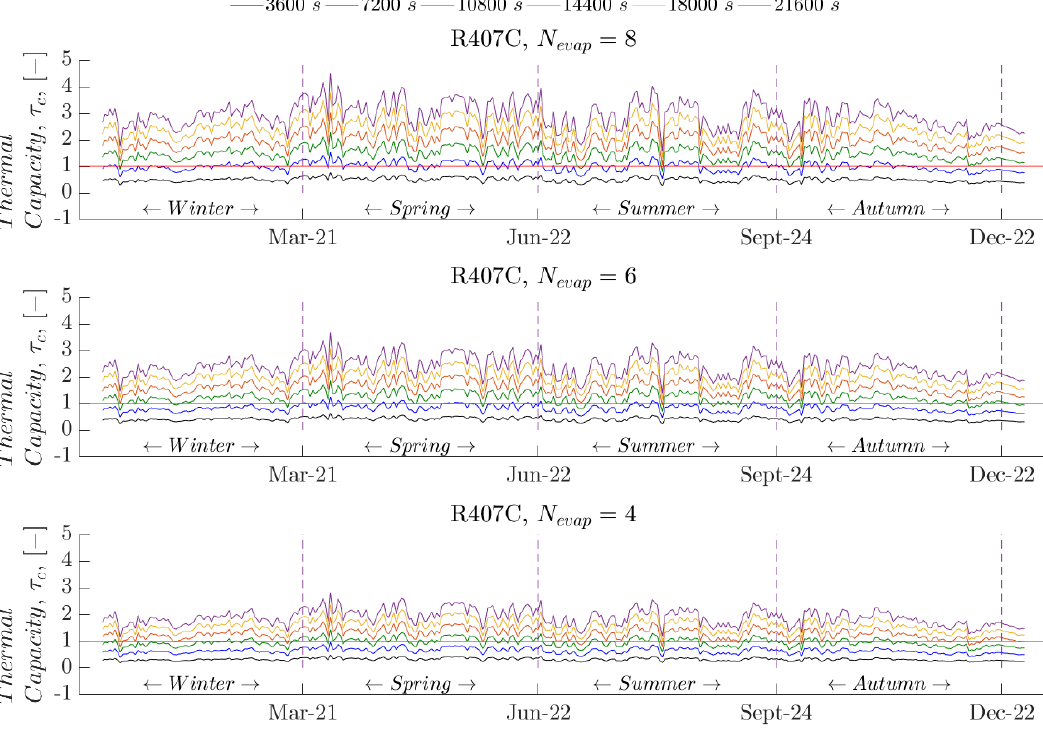
Figure 6. Thermal capacity of the heat pump during the year using R410A as working fluid.